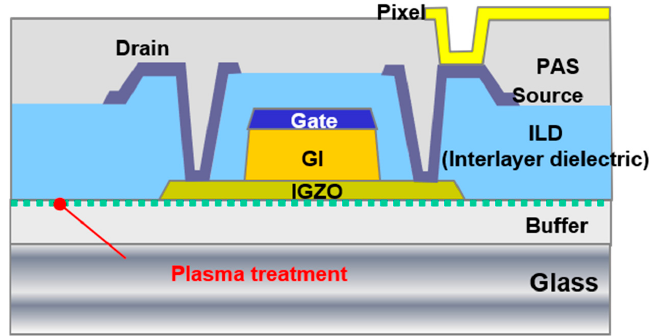
Figure 1. Cross-sectional view of the coplanar indium–gallium–zinc–oxide (IGZO) thin-film transistor (TFT) studied in this